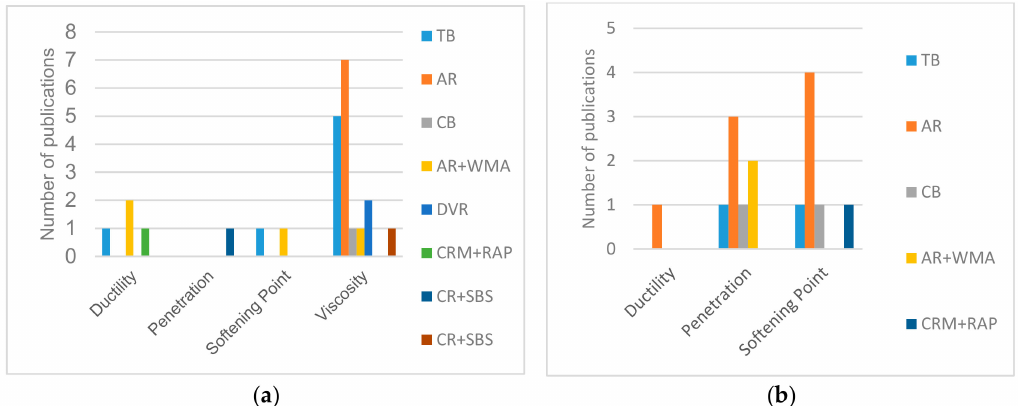
Figure 8. ( a ) Number of publications where the results report a higher value for the analyzed characteristic of different CRM binders compared to the traditional binder, and ( b ) number of publications reporting a lower value for the considered characteristics for CRM binders compared to the traditional binder. Note that in Figure 8b, the viscosity is not present because in all the results of the papers analyzed, the addition of the rubber always increases the viscosity of the